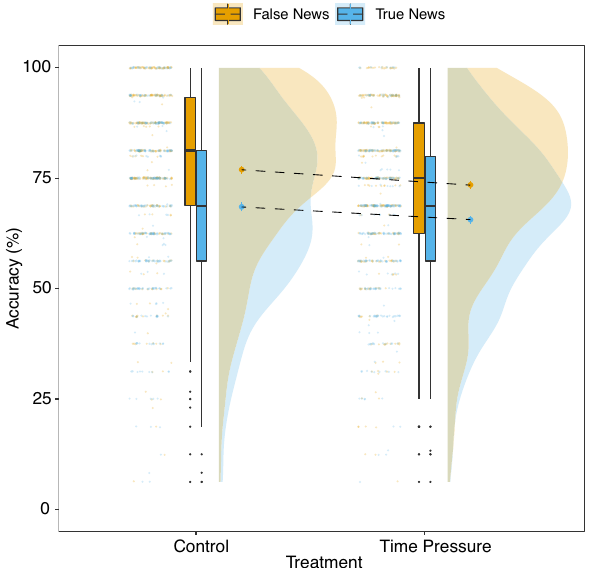
Figure 2. Accuracy (in percentages) for true and false news headlines across the two treatments. The small coloured dots represent the mean accuracy of each individual. The boxplots show the median value and the IQR. The whiskers indicate an additional 1.5 IQR and the small black dots represent outliers. The large coloured dots represent the aggregate mean with standard errors. The density plots describe the distribution of the data. Under time pressure, accuracy was reduced for both true and false headlines (negative slope of dashed lines). In other words, time pressure reduced discrimination ability. Time pressure did not, however, alter the response bias: Accuracy for both true and false news decreased at an equal rate under time